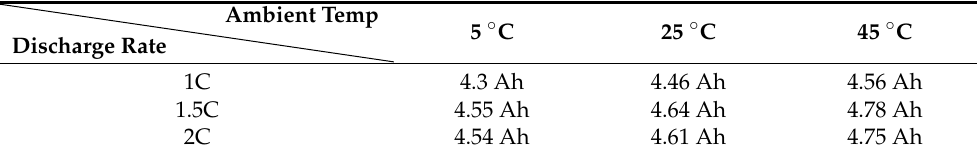
Figure 3. Ba tt ery SOC–OCV curve. Figure 3. Battery SOC–OCV curve. Table 4. Actual battery Table 4. Actual ba tt ery capacity.